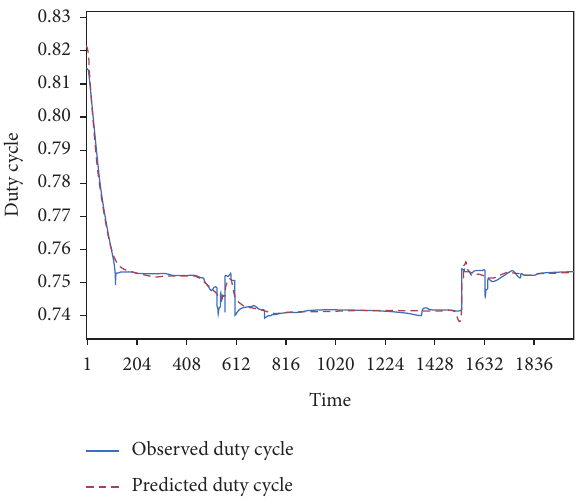
Figure 43: The simulated plot comparing the measured and predicted duty